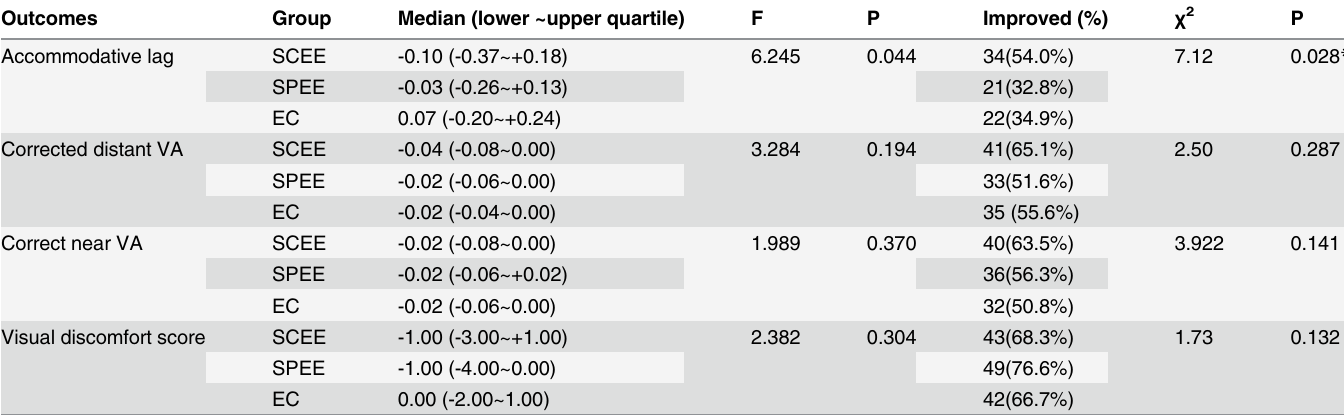
Table 3. Changes in accommodative lag and other secondary outcomes before and immediately after different eye exercises.